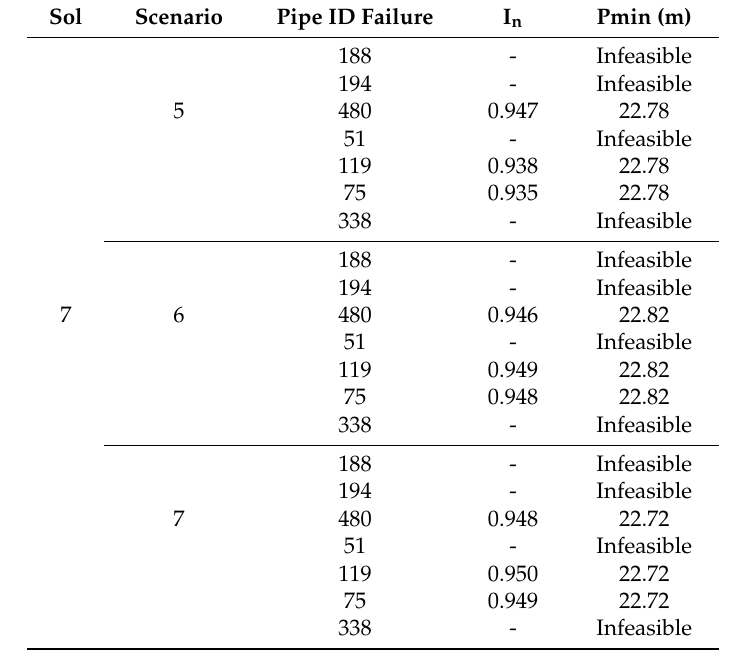
Table 11. Characteristics of BIN solution 7 for each demand scenario combined with pipe failure.